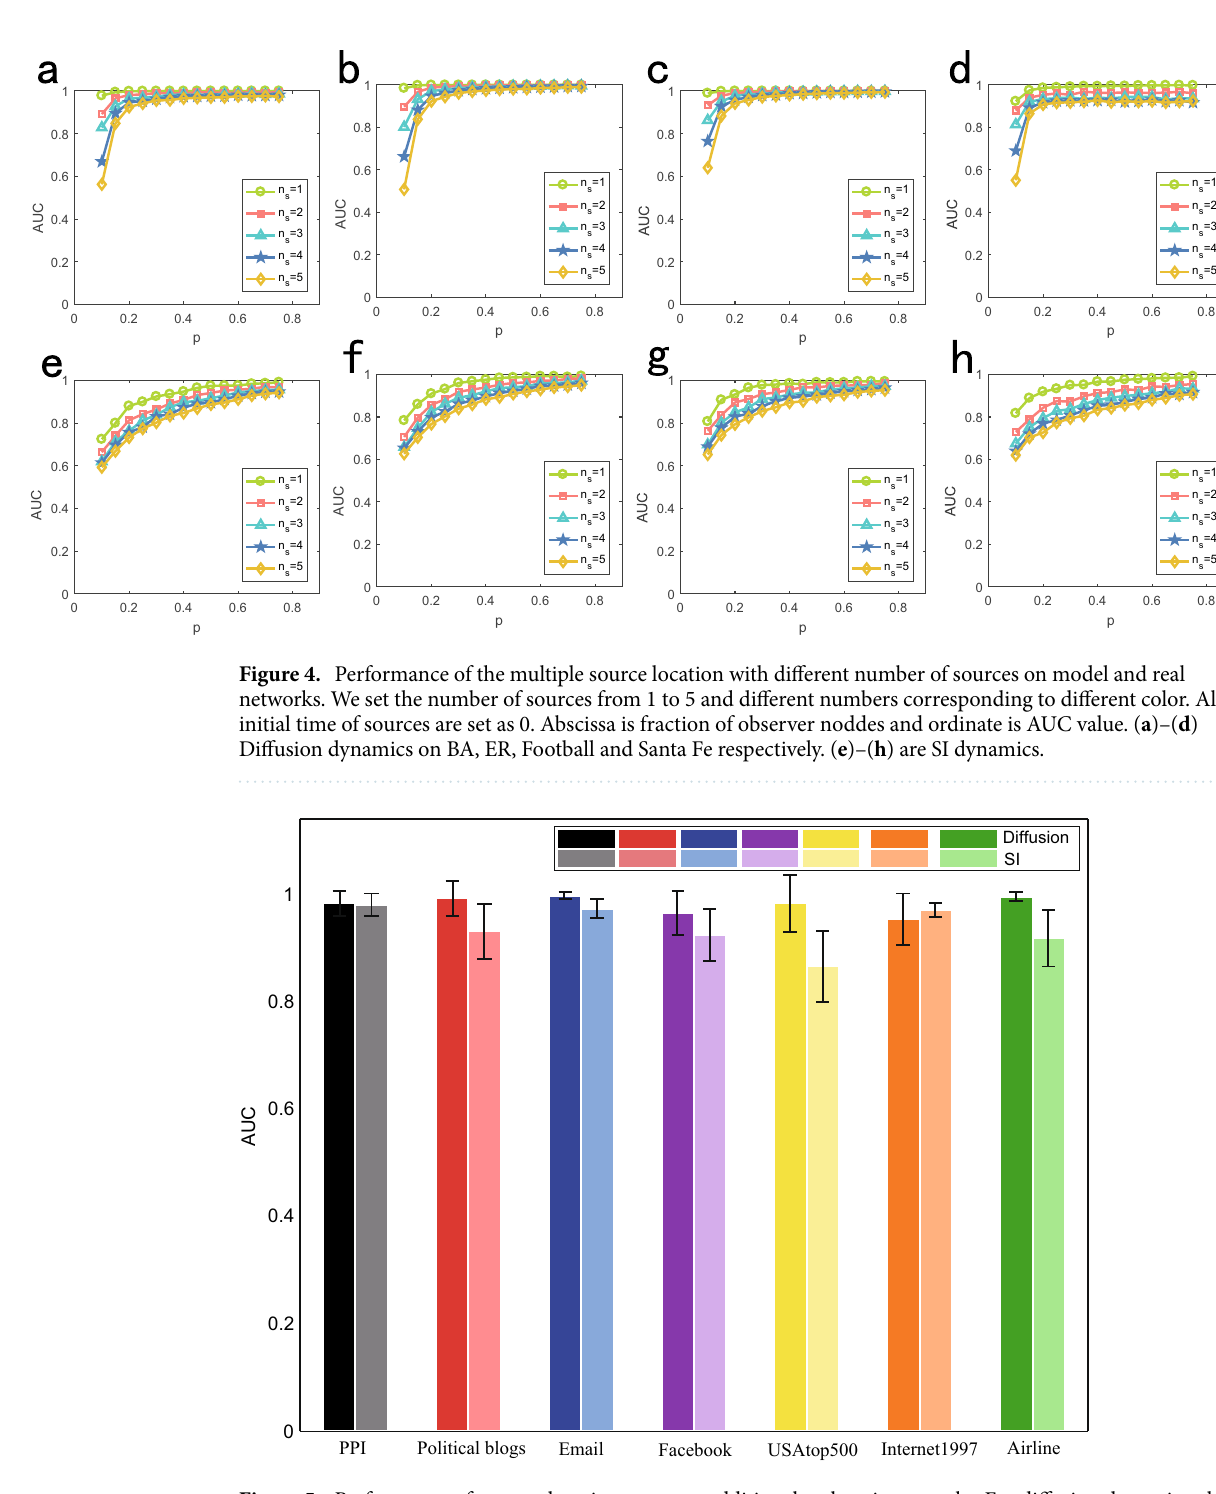
Figure 5. Performance of sources location on seven additional real static networks. For diffusion dynamics, the time delay of edges follows Gaussian distribution N ( u , σ 2 ) with u = 2 and σ = 0.25 and we set informed rate as (cid:31) = 0.5 for SI dynamics. Randomly select 30% of nodes as observer nodes. We set two sources and which are randomly selected. All values are average of 100 simulations, and the error bars are standard